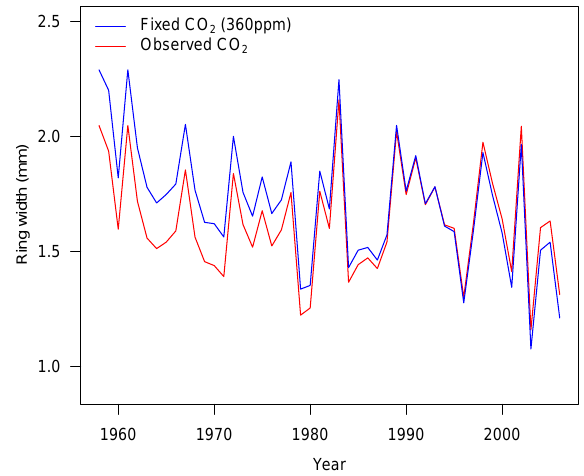
Figure 6. CO 2 effect on tree growth. Two runs, one with a fixed 360ppm [CO 2 ] (blue line), the other with observed monthly [CO 2 ] (red line), are compared to show the simulated effect of [CO 2 ] on tree growth during the period